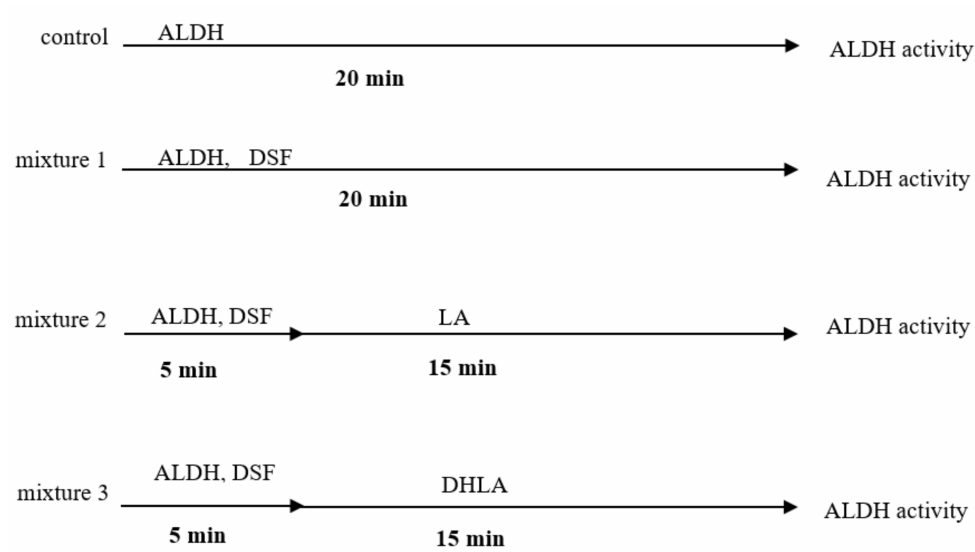
(ALDH) by disulfiram (DSF) in the presence or absence of lipoic acid (LA) and dihydrolipoic